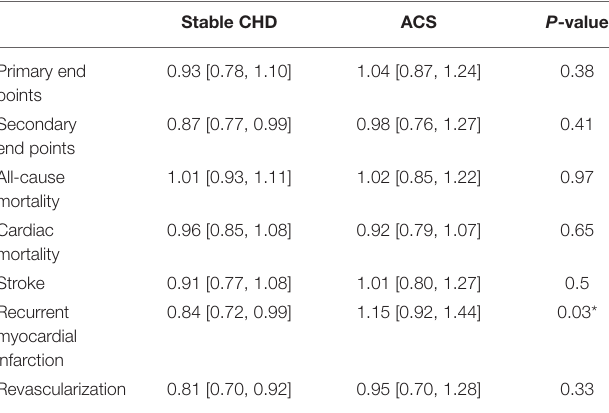
TABLE 2 | Different efficacies of anti-inflammatory agents between stable CHD and ACS. Stable CHD ACS P